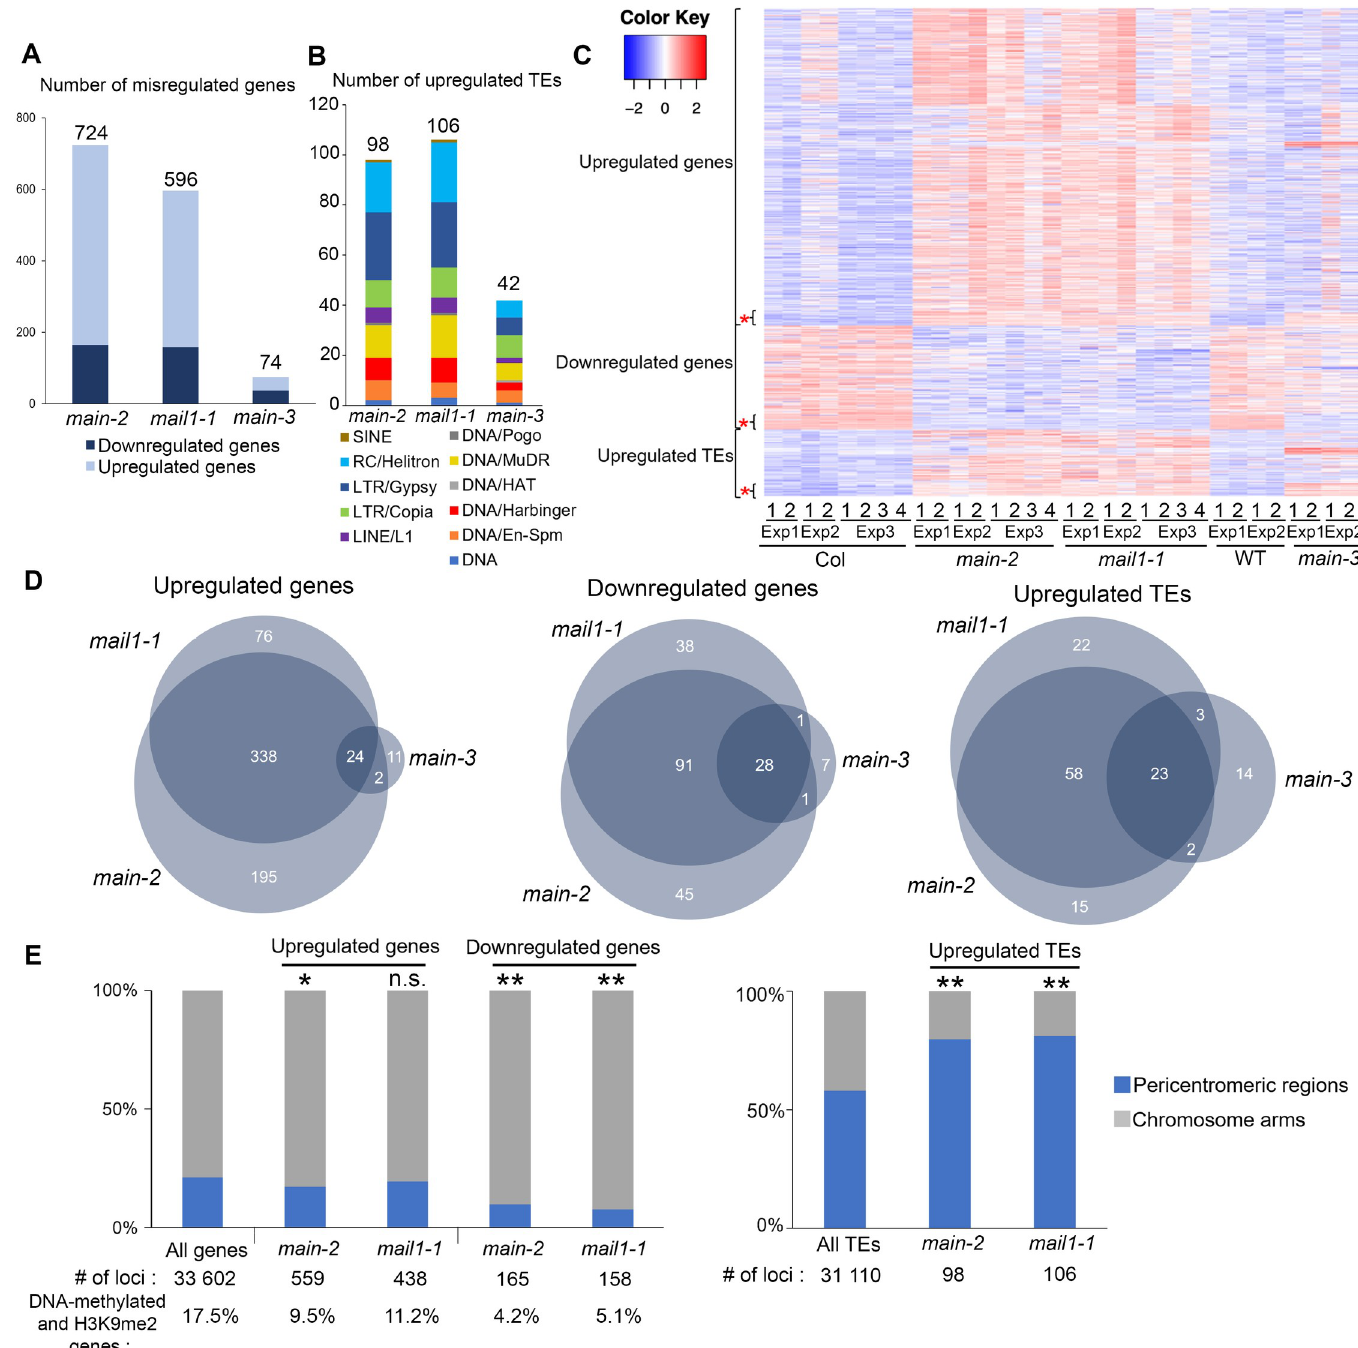
Fig 3. MAIN and MAIL1 are required for the proper expression of similar genes, and for TE silencing. (A-B) Number of misregulated genes (A) and upregulated TEs (B) in main-2 , mail1-1 and main-3 mutants in comparison to WT Col plants. TEs are classified by superfamily. (C) Heatmap showing misregulated loci in main-2 , mail1-1 and main-3 in comparison to Col and WT controls, respectively. Asterisks represents loci that are commonly misregulated in the three mutant backgrounds. (D) Venn diagrams analyses representing the overlaps between misregulated loci in main-2 , mail1-1 and main-3 . Fisher’s exact test statistically confirmed the significance of Venn diagram overlaps (p-value < 2.2.10e-16). (E) Fraction of misregulated loci in main-2 and mail1-1 located in chromosome arms or in pericentromeric regions as defined in [50]. Asterisks indicate statistically significant enrichments of downregulated genes and upregulated genes and TEs in chromosome arms and pericentromeric regions, respectively, in comparison to the genomic distributions of all A . thaliana genes and TEs (Chi-Square test, � : p-value � 0.05, �� : p-value � 0.01, n.s: not significant). Percentages of genes targeted by DNA methylation and H3K9me2 were calculated based on enrichment in heterochromatin states 8 and 9 as defined in [51]. RNA-seq threshold: log2 � 2, or log2 � -2; p-adj < 0.01.